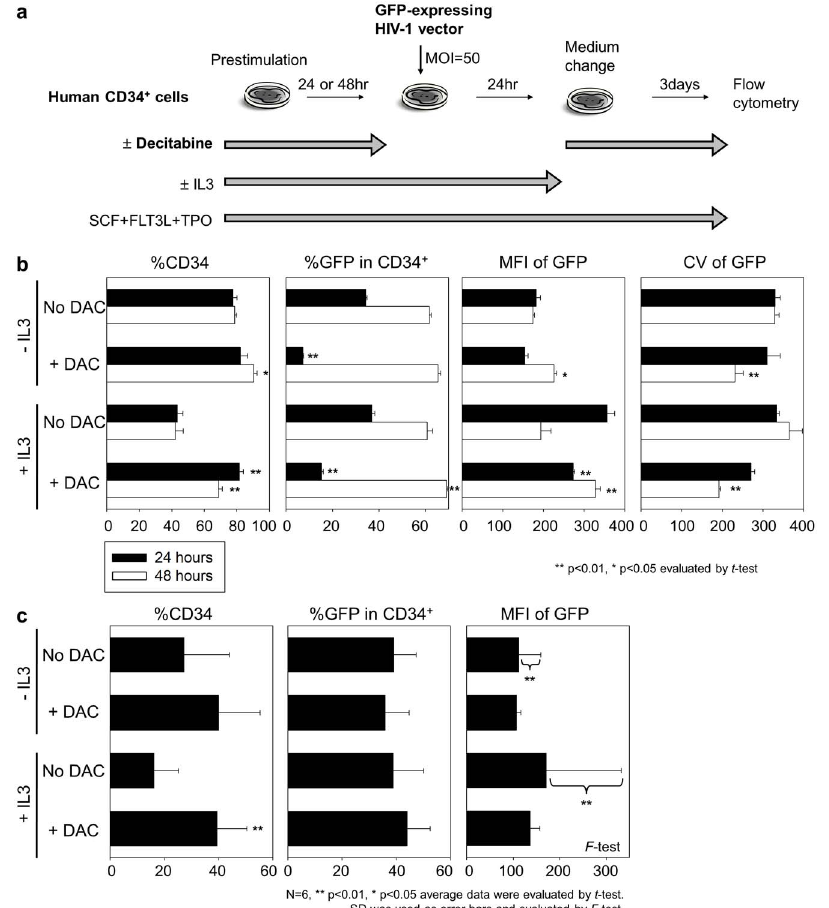
Figure 3. 48-hour decitabine exposure resulted in equivalent %GFP in transduced human CD34 + cells. (a). To evaluate whether transduction efficiency is changed by interval of time between decitabine exposure and transduction, we compared %GFP between 24-hour and 48- hour prestimulation. Human CD34 + cells were cultured in serum-free media containing cytokines (SCF, FLT3L, and TPO) supplemented with decitabine (0.5 m M). At 24 or 48 hours after starting exposure with or without decitabine, the cells were transduced with GFP-expressing HIV-1 based lentiviral vectors without decitabine for 24 hours. In addition, we investigated supplement of IL3 into media during prestimulation and transduction. (b). After 48-hour prestimulation, decitabine exposure resulted in higher %CD34, equivalent %GFP, and lower coefficient of variation (CV) of GFP intensity, while %GFP decreased in 24-hour decitabine exposure. (c). In transduction of CD34 + cells obtained from six healthy donors, average data revealed similar trends of higher %CD34 and equivalent %GFP after 48-hour decitabine exposure (0.5 m M). In addition, the decitabine exposure reduced standard deviations (SD) of GFP intensity among transduced CD34 + cells from six individuals (right panel). We tested statistical significance of data in all decitabine exposure groups, compared to no decitabine